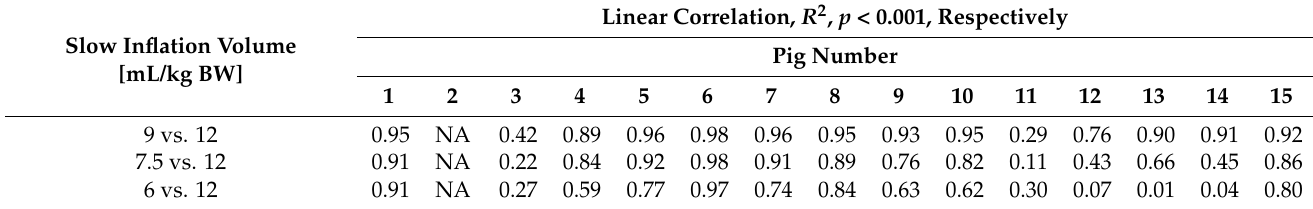
Table 2. Intraindividual linear correlation analysis of